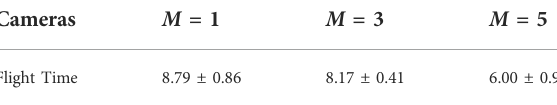
Frontiers in Robotics and